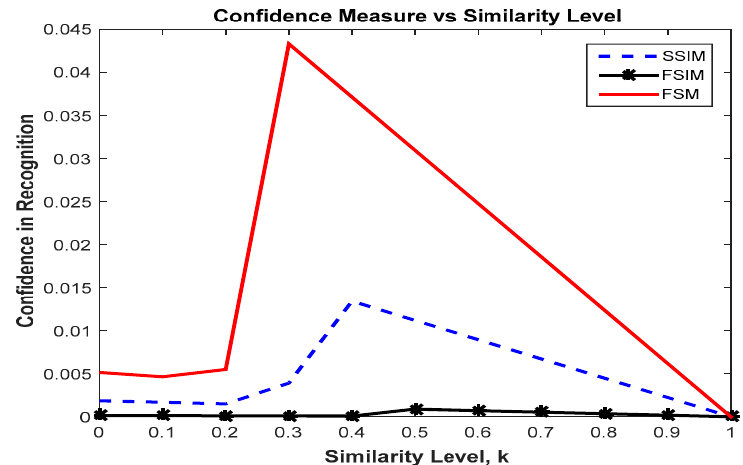
Figure 15. Recognition confidence for similarity measures SSIM, FSIM and FSM using person No. 15 (pose 7) in FEI database.